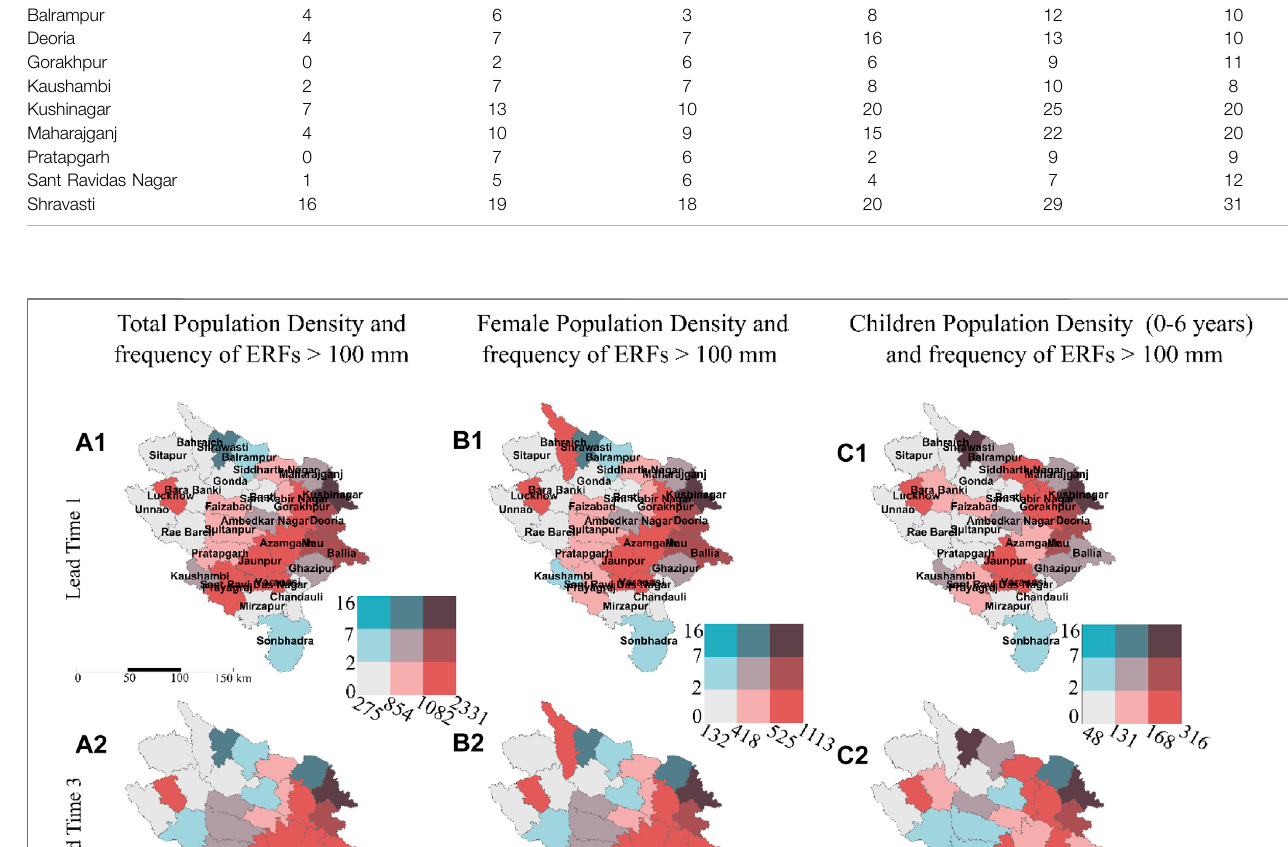
Frontiers in Earth Science |